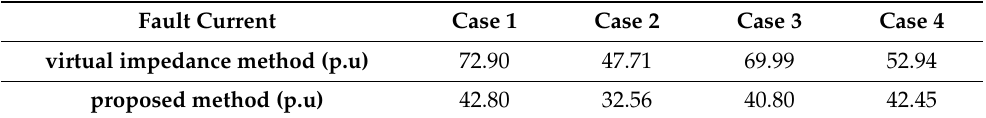
Table 2. The estimated short circuit current at bus No. 8 for four different cases.